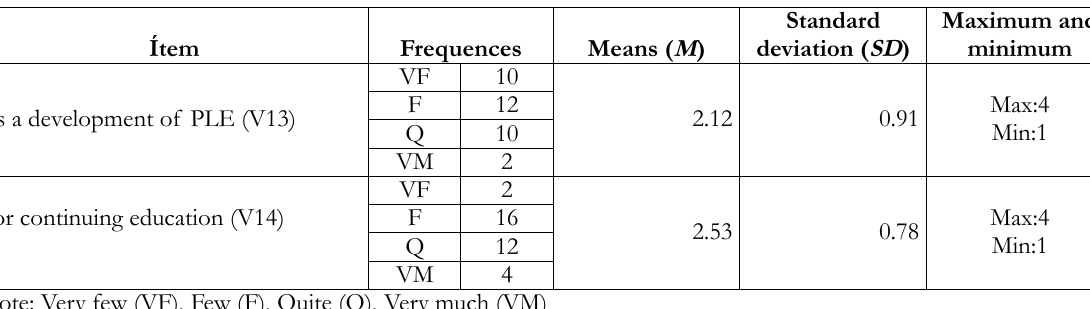
Table 3. Dimension values linked to the use of ICT by teachers in their